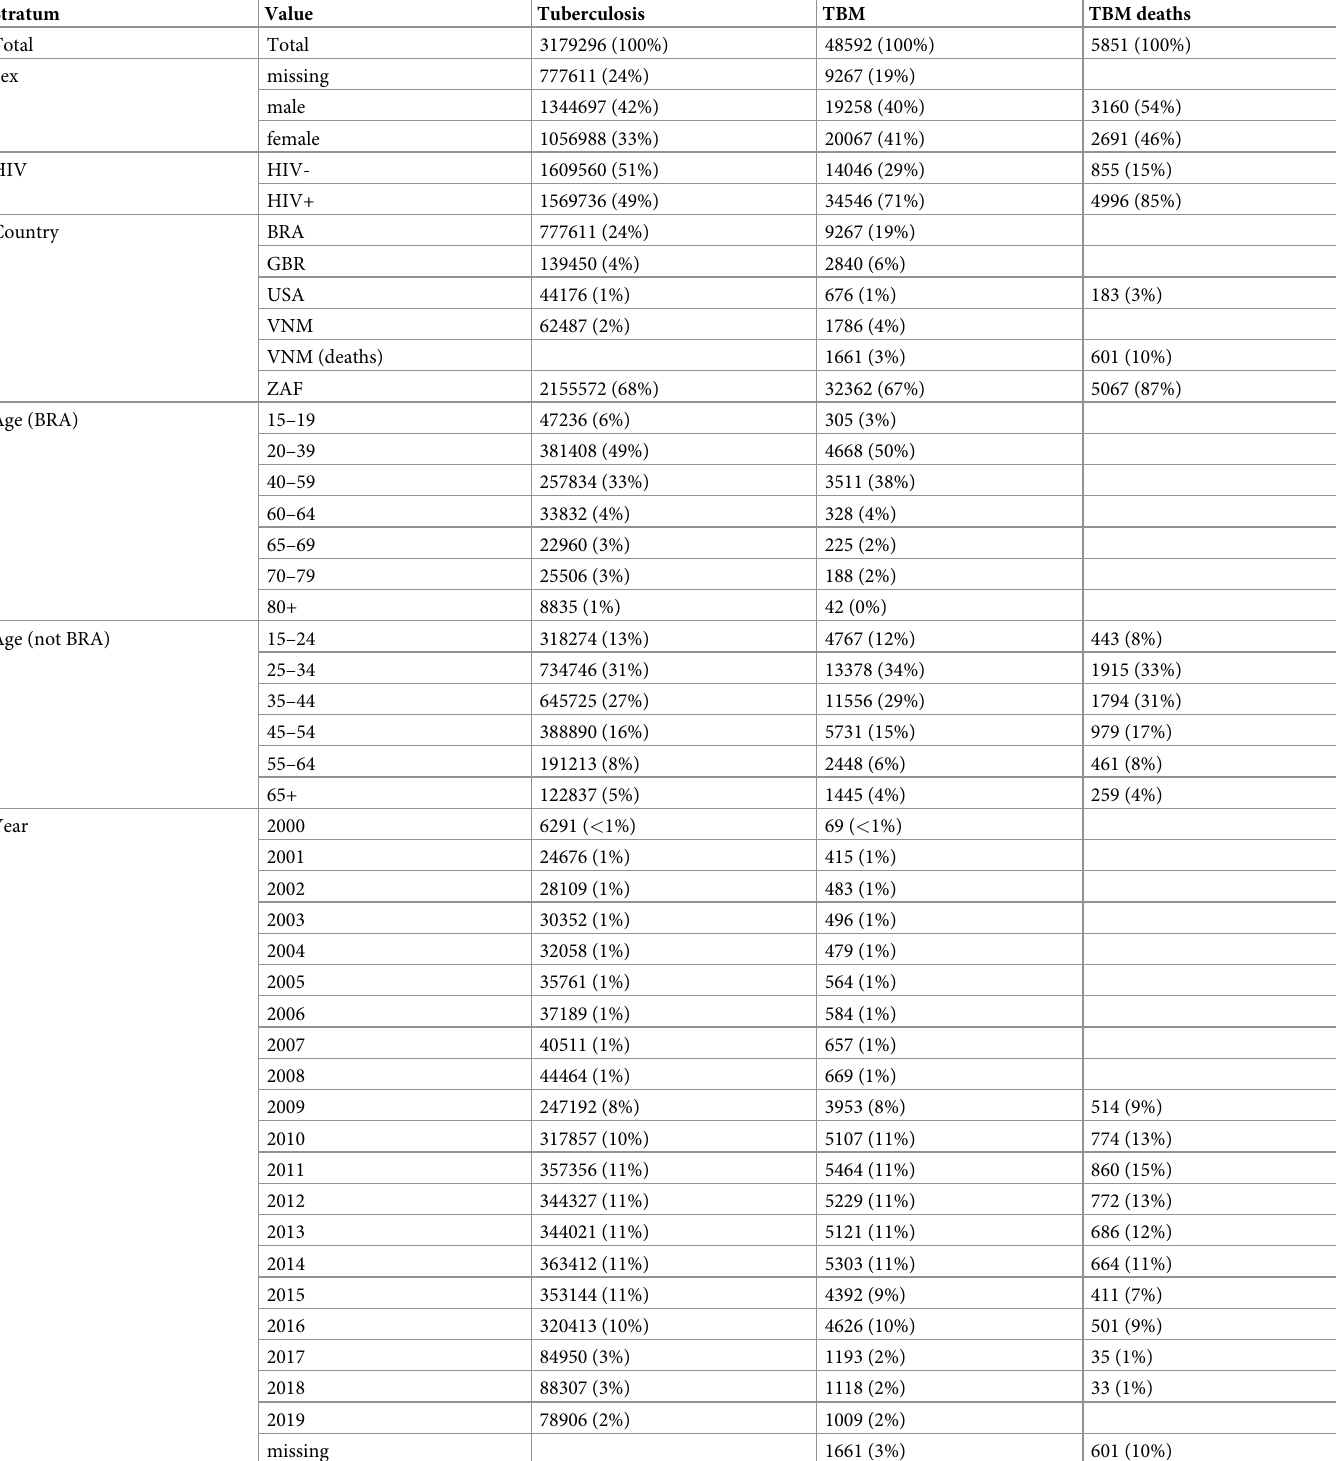
Table 1. Number of people included in meta-analysis by characteristic (rows) and type (columns). Percentages of counts within strata are shown in brackets. Blanks indicate no data. Stratum